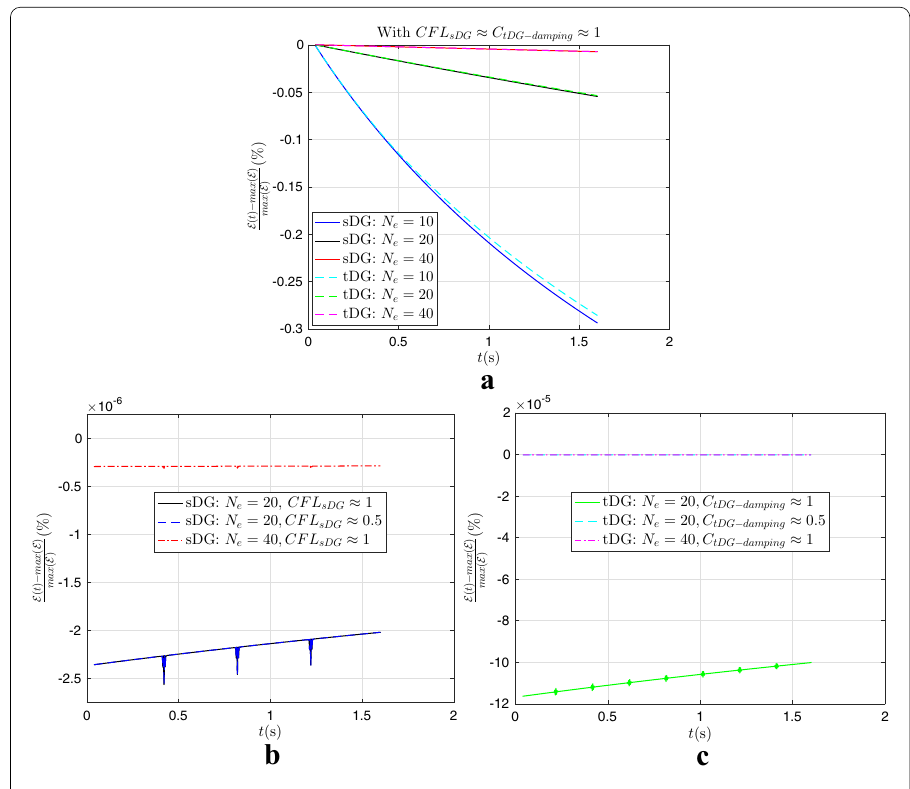
Fig. 4 Influence of ( h E = λ min , (cid:6) t ) on the numerical damping for a both space and time dG methods with N e CFL sDG ≈ C tDG − damping ≈ 1; b for the space dG method; c for the time dG